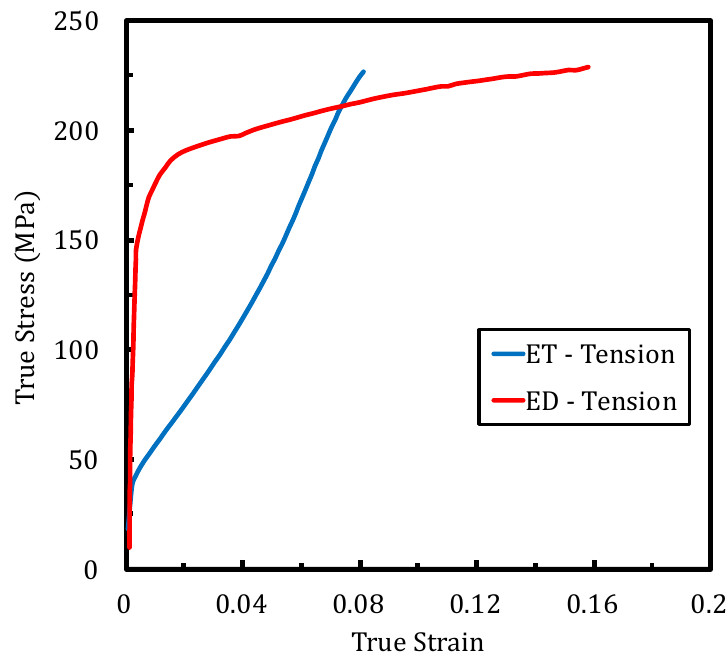
Figure 5. Stress-strain relationship of AM30 alloy in extrusion and extrusion transverse (ET) directions. A sigmoidal curve for tension along the ET direction indicates high strain hardening, which is characteristic of profuse tension twinning, while tension along the extrusion direction (ED) alludes to deformation due to slip with minimal twinning [36] (with the permission of Elsevier,